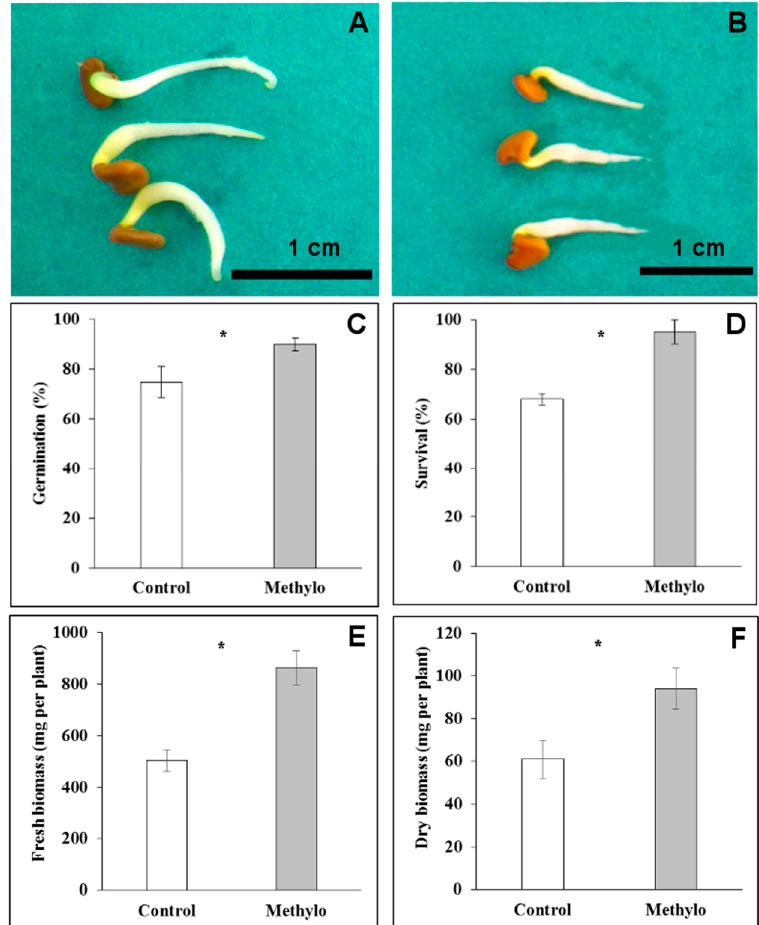
Figure 6. Control seedlings of Crotalaria pumila ( A ) and seedlings inoculated with Methylobacterium sp. Cp3 ( B ) at five days after start of germination. Percentage of germination ( C ); survival rate ( D ); and, fresh ( E ) and dry biomass ( F ) of inoculated and non-inoculated plants. * significant difference between treatments according to t -test ( p < 0.05), mean ± standard deviation.